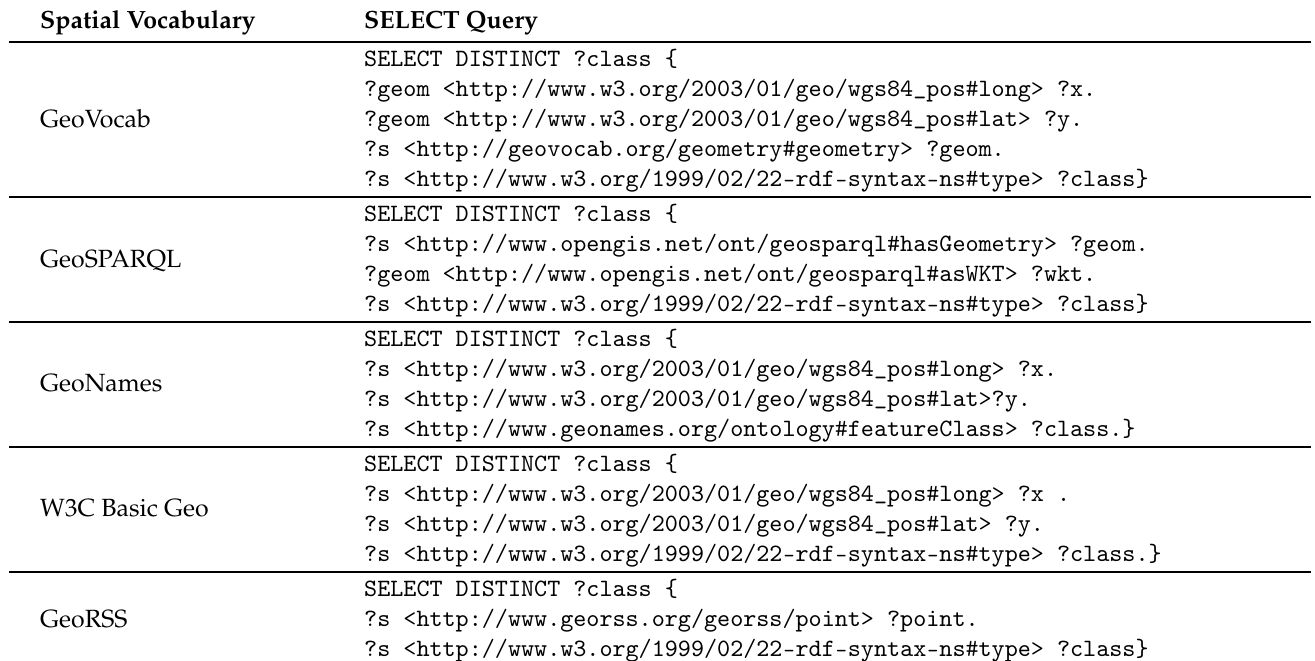
Table 1. SELECT SPARQL queries for retrieving dataset spatial classes.